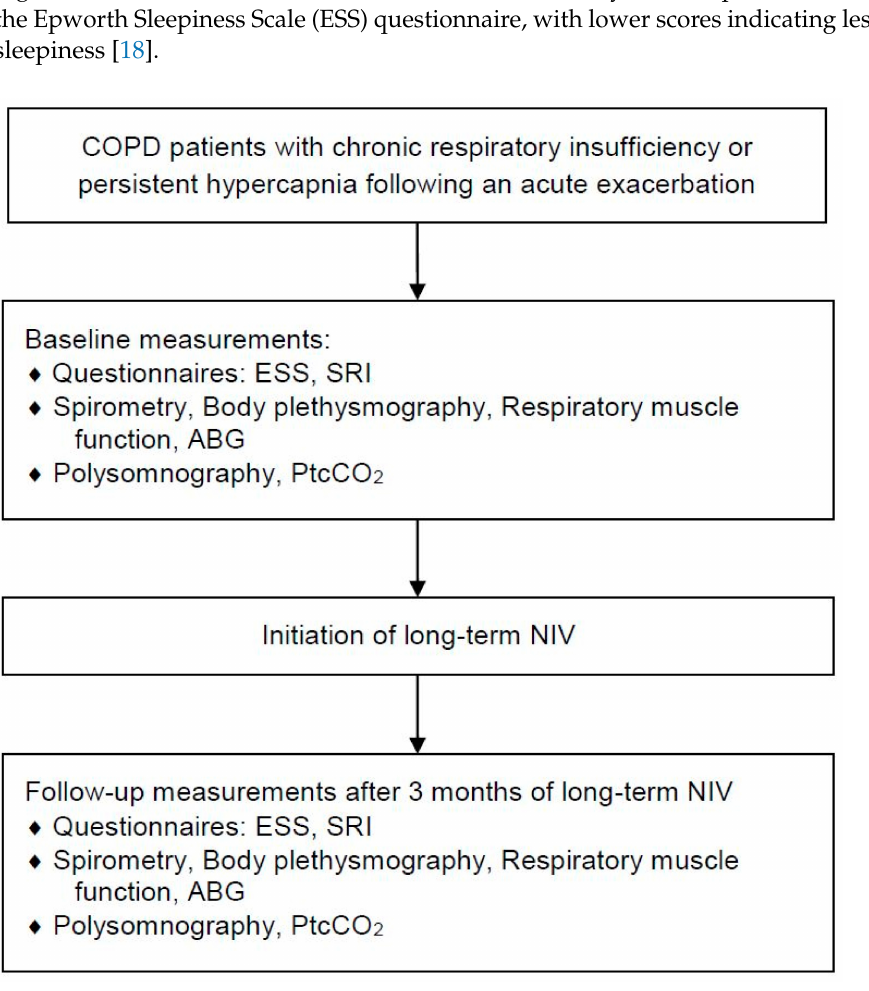
Figure 1. Flow chart of study design and measurements. Abbreviations: NIV: non-invasive venti- lation, ESS: Epworth Sleepiness Scale; SRI: Severe Respiratory Insufficiency Questionnaire; ABG: arterial blood gas analysis; PtcCO 2 : transcutaneous PCO 2